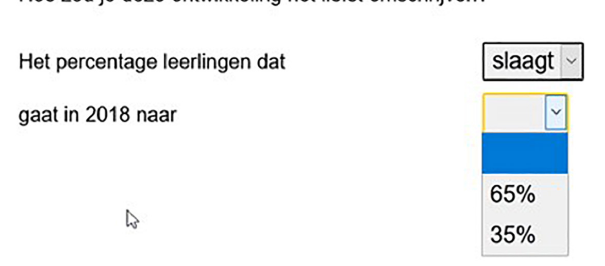
FIGURE 4 | Screen shot of the answering format in the dynamic task (experiment 2). Translation: how would you prefer to describe this development? The percentage of pupils passing (failing) develops in 2018 into. 65/35%. Note: this translation is a gloss of the Dutch word order.